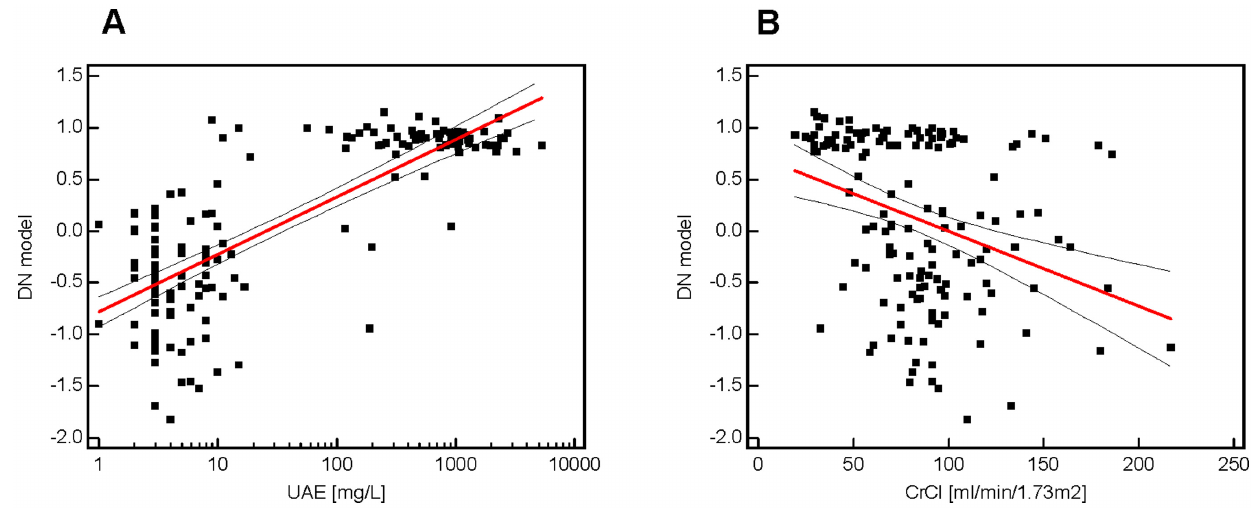
Figure 3. Correlation analysis. Scatter diagrams of correlation from proteomic biomarker pattern with urinary albumin excretion (UAE) ( A ) and creatinine clearance ( B ). The red line shows the regression line with 95% confidence interval (dashed line).